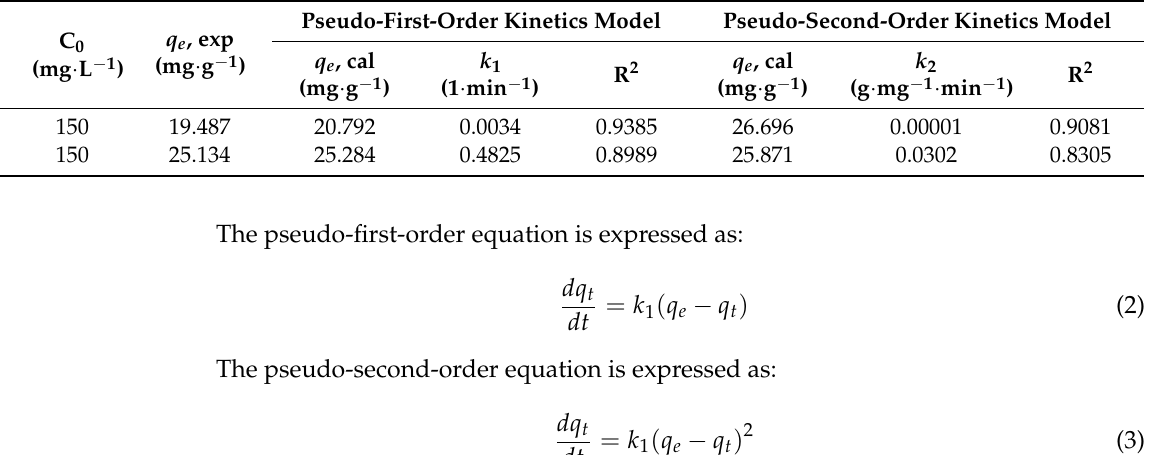
Table 1. Pseudo-first-order and pseudo-second-order kinetics models for Cd(II) adsorption on B 600 and Cs-Fe 3 O 4 -B 600 .